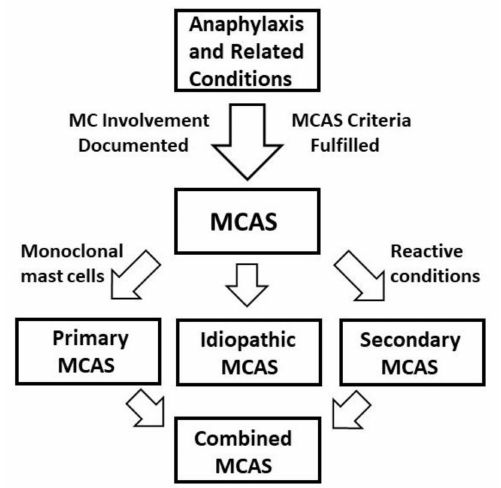
Figure 1. Algorithm in Patients with Suspected